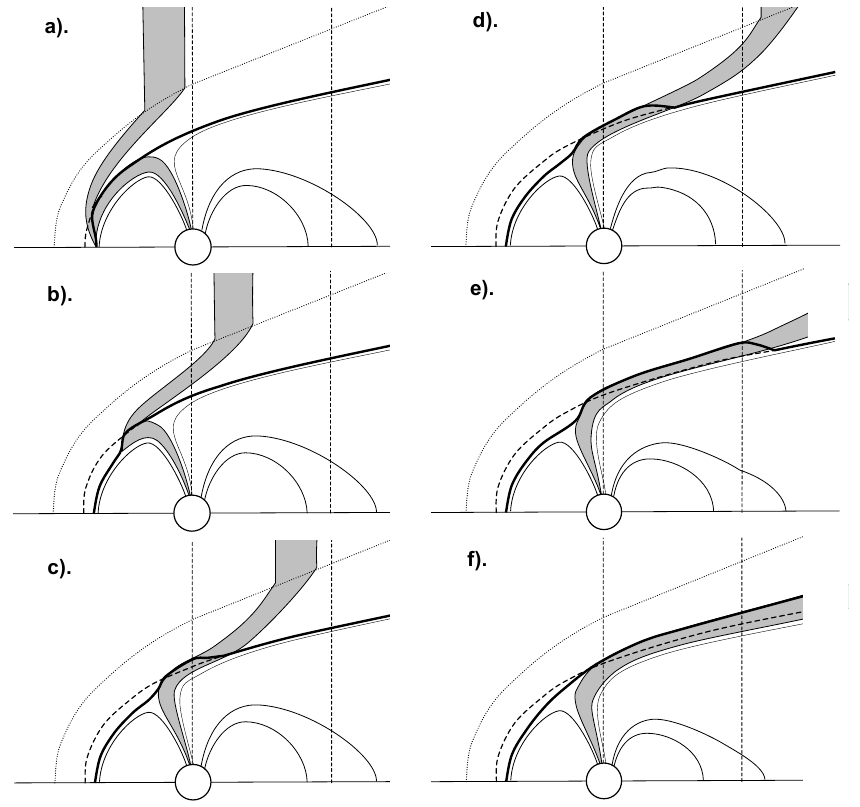
Fig. 2. Schematic noon-midnight cross-sections of the northern hemisphere magnetosphere, illustrating the evolution of newly-opened flux, shaded gray, as it is appended to the tail lobe by the solar wind flow following subsolar reconnection. The heavy solid line is the magnetopause current sheet, the dashed line shows its location prior to the reconnection pulse which produced the newly-opened flux. The dotted line is the bow shock and the two vertical lines are magnetospheric cross-sections at [ X ] GSM = 0 and [ X ] GSM = − 30 R E . Thin lines are geomagnetic field